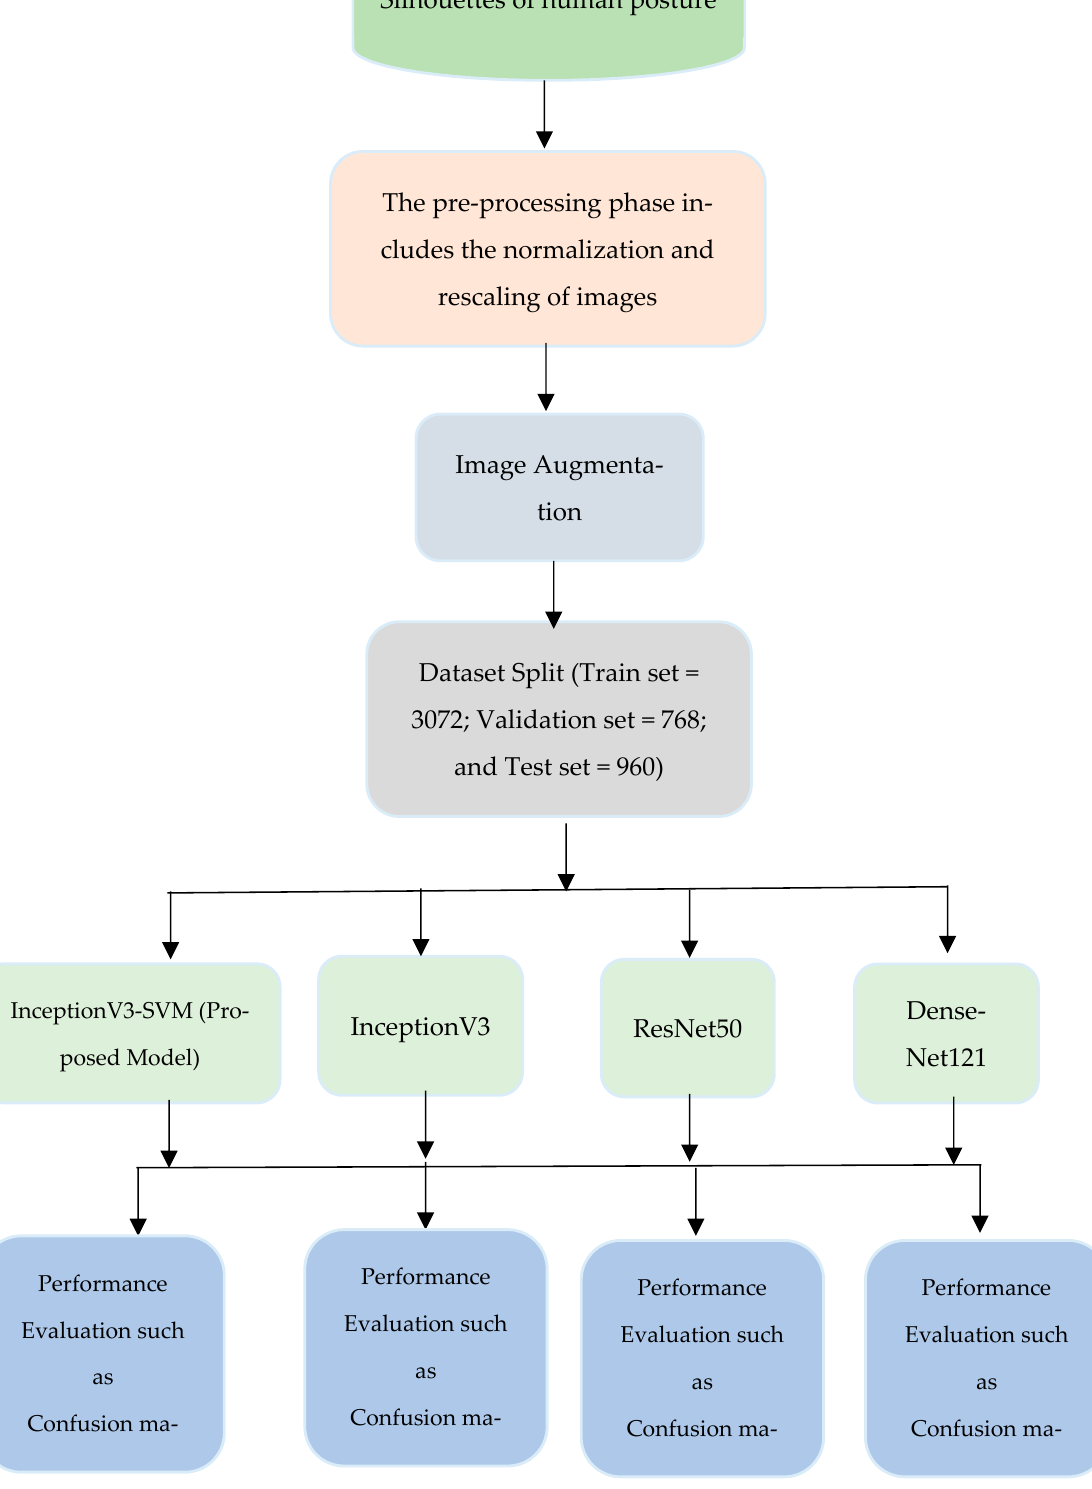
Figure 1. Proposed system block diagram